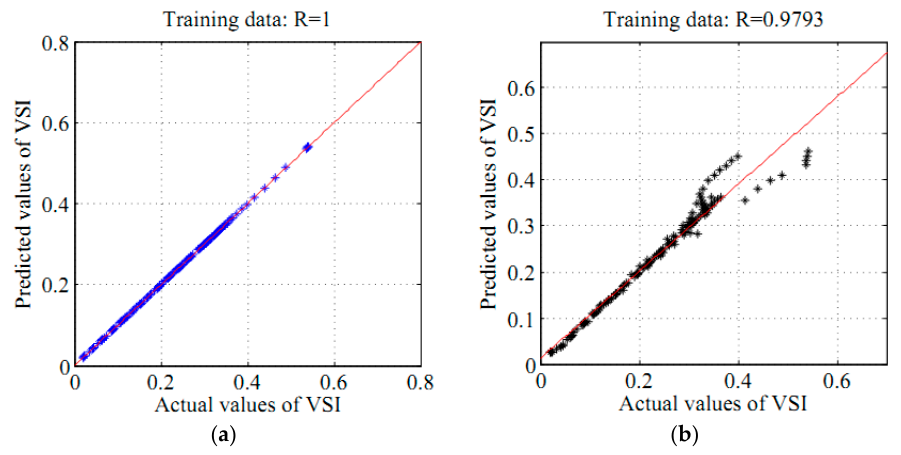
Figure 7. Linear fits between the actual and predicted VSI for IEEE 118-bus in training phase using ( a ) ALO-SVR; ( b ) ANFIS.